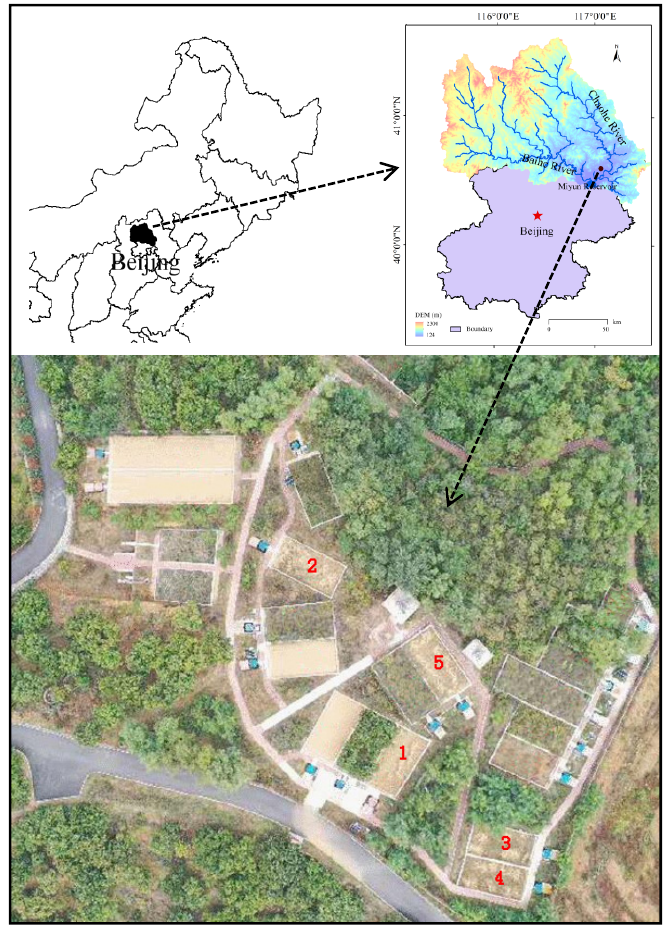
Figure 1. Location of the study area and the cultivated runoff plot selected. The red figures represent the plots in Table 1 (The bottom map showing the plots’ distribution was edited from Xu [27]).